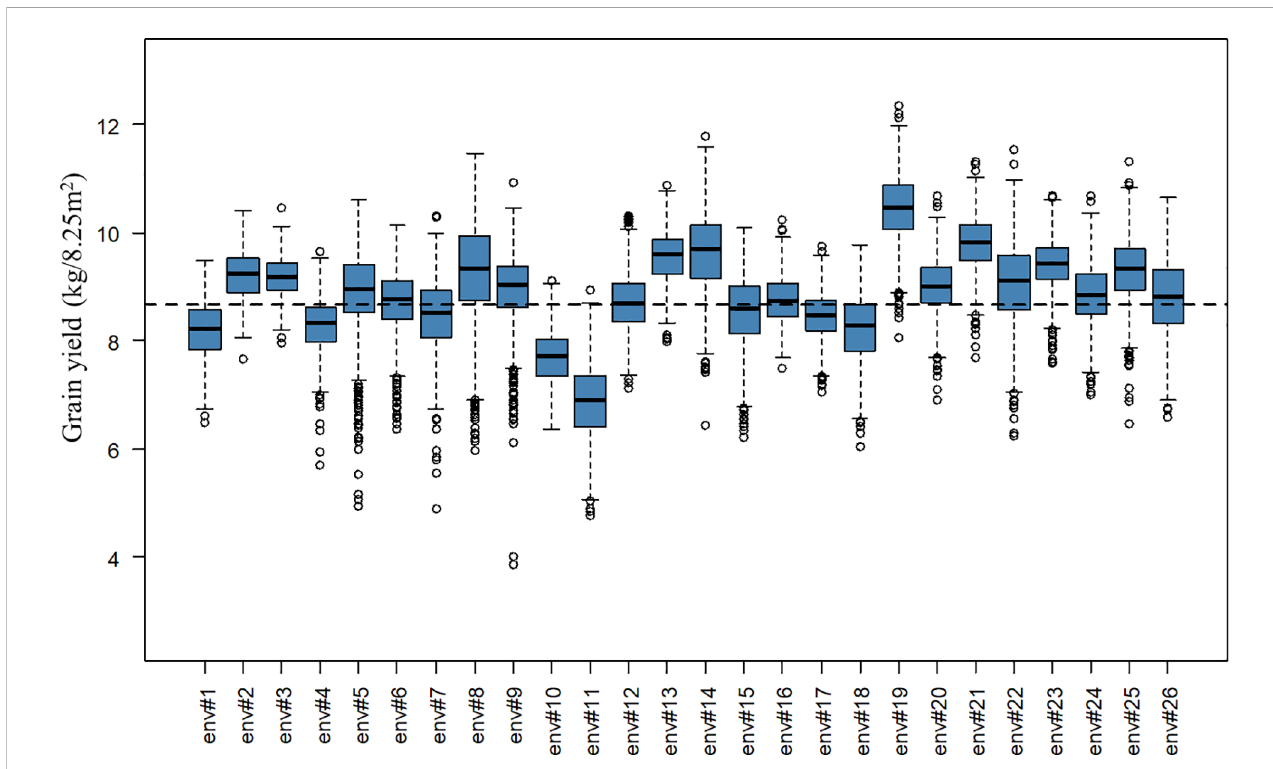
FIGURE 1 Boxplot of grain yield (kg/8.25m 2 ) per year-location subset. The x-axis labels “ env#1 ” to “ env#26 ” indicates the 26 year-location environments where lines were tested. The black dashed line represents the overall average grain yield for the complete